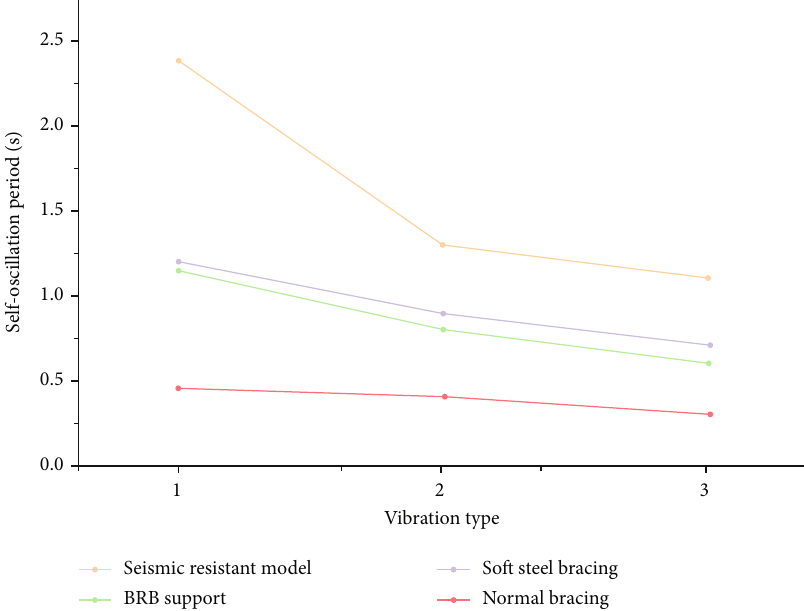
Figure 6: Periodic comparison between the seismic-resistant model and the three types of seismic-damped model under the three waves. The vertex displacement diagram of the top displacement of the structure in Figure 8, curves of LTB400, LTB500, and LTB600 in the seismic- the top displacement of the fi ve types of structures incorpo- isolated system almost overlap and are smaller than the ver- rating seismic isolation bearings and the three types of struc- tex displacements generated by high damped and friction tures with bracing are all smaller than the seismic-resistant